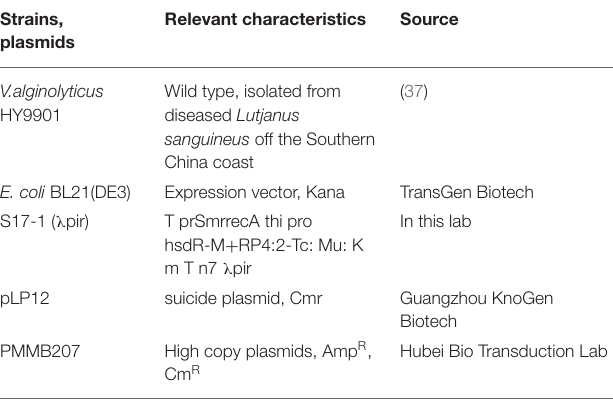
TABLE 1 | Bacterial strains and plasmids used in this study. Strains, Relevant plasmids